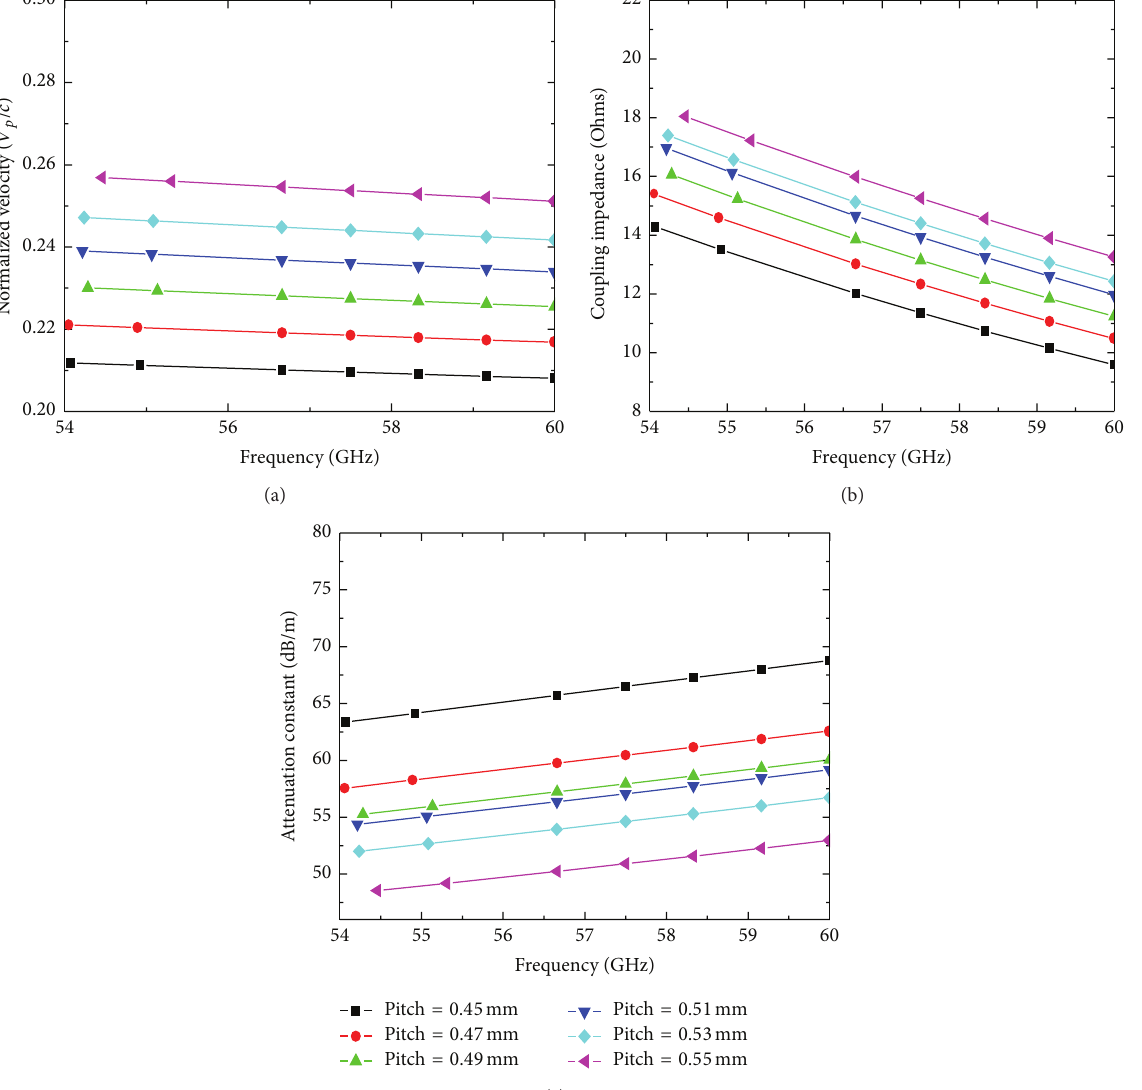
Figure4:(a)Dispersion,(b)couplingimpedance,and(c)attenuationconstantforthehelixSWSwithpitchrangingfrom0.45 mmto0.55 mm.